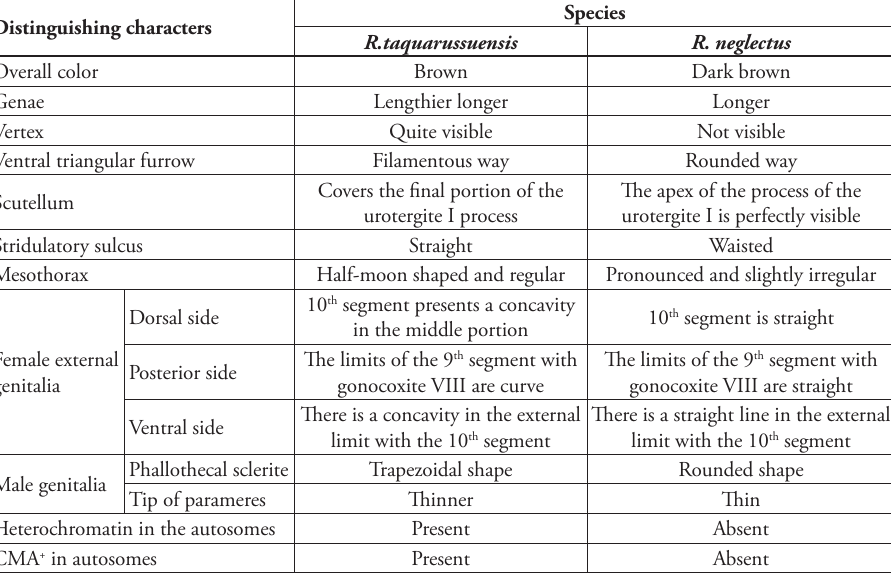
Table 2. Main distinguishing characters between R.taquarussuensis sp. n. and R. neglectus. Distinguishing